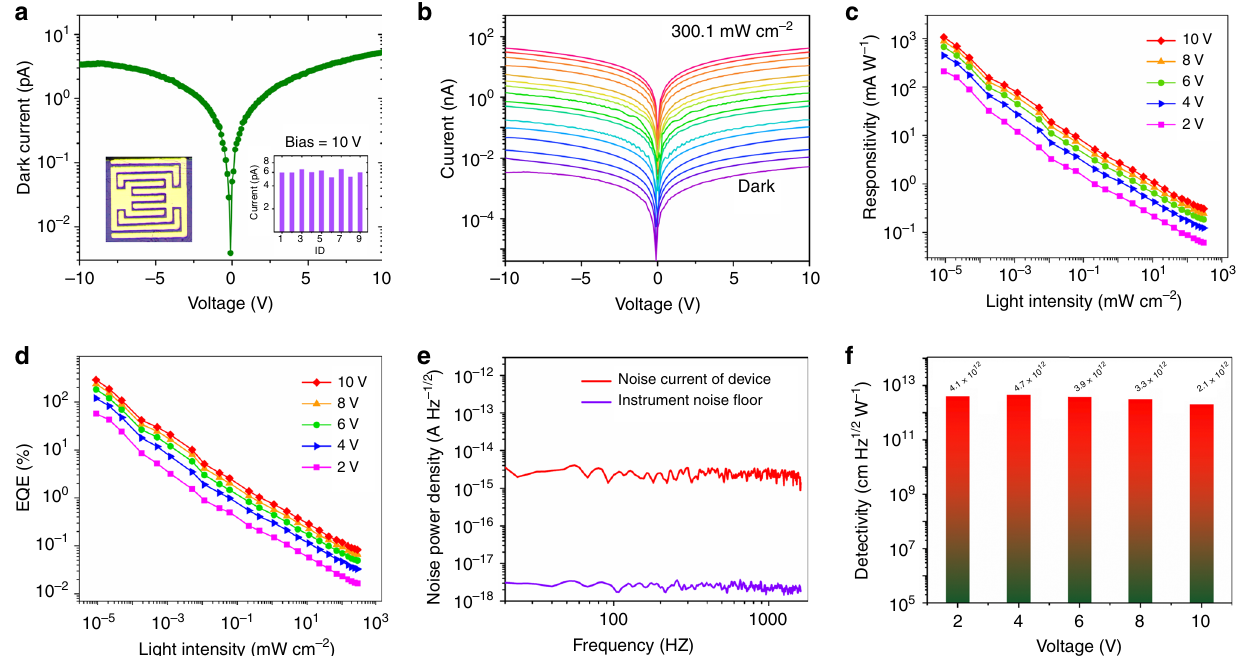
Fig. 4 Performance of Cs 3 Bi 2 I 9 PSC photodetector. a Dark I – V curve of the Cs 3 Bi 2 I 9 PSC photodetector with the right-hand inset showing dark current statistics for different devices measured at 10 V bias and the left-hand one device con fi guration. b I – V curves of the Cs 3 Bi 2 I 9 PSC photodetector measured in the dark and with illumination at intensity from 9.2 × 10 − 6 to 300.1 mW cm − 2 , λ = 462nm. c Light-intensity-dependent responsivity and d external quantum ef fi ciency of the Cs 3 Bi 2 I 9 PSC photodetector measured at various biases. e Measured dark-current noise of the Cs 3 Bi 2 I 9 PSC photodetector at 4 V bias. f Detectivity of the Cs 3 Bi 2 I 9 PSC photodetector measured at various